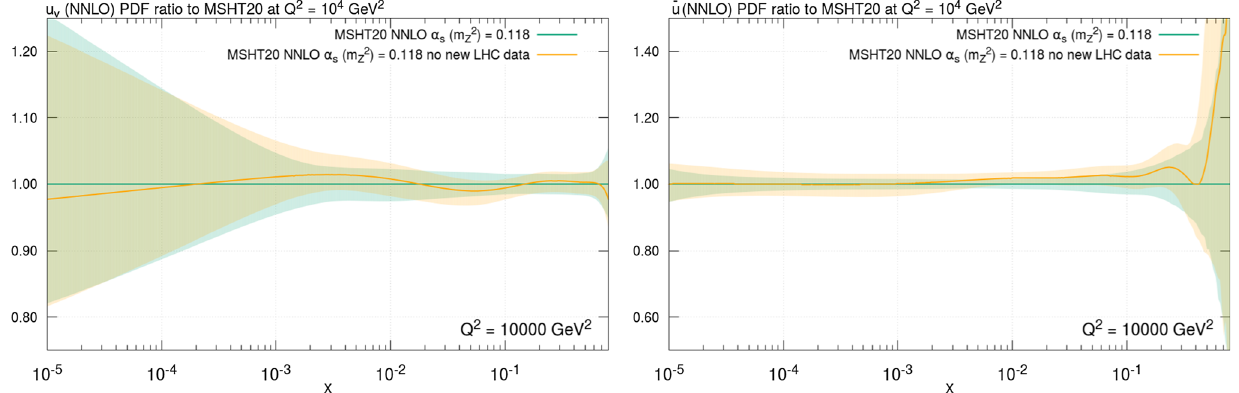
Fig. 49 (Left) Up valence and (right) up antiquark PDF ratios to the default MSHT20 default fit showing the effect of the removal of new LHC data at Q 2 = 10 4 GeV 2 at NNLO